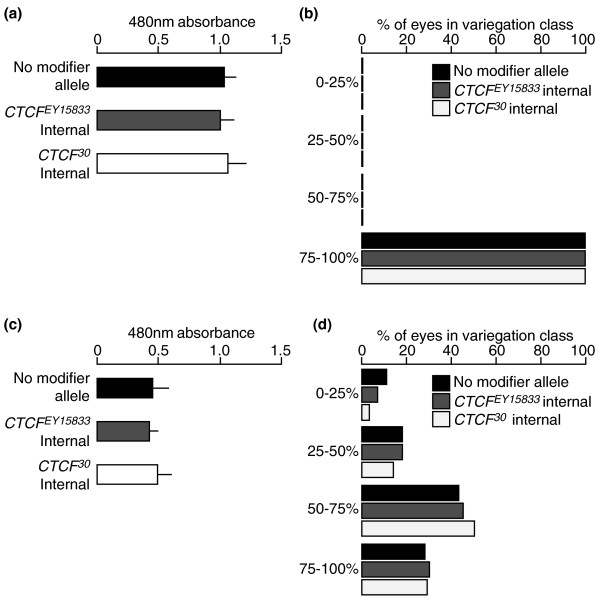
Absence of maternal or paternal effects from mutant dCTCF on Dp(1;f)LJ9 garnet expression. External control progeny (no modifier allele) have the same genotype as internal control progeny (y1zag53d/Dp(1;f)LJ9; TM3, Sb Ser/+) but are generated from a separate cross with parents that have never encountered a mutant CTCFX allele. (a) Maternally inherited Dp(1;f)LJ9 CTCFX internal control eye pigment levels; no significant difference in pigment levels was observed between external control progeny (no modifier allele) and internal control progeny from fathers carrying CTCFX (CTCFX internal), demonstrating that no paternal effect occurs. (b) Phenotypes of maternally inherited Dp(1;f)LJ9 ranging from 0% to 100% pigmentation; No modifier allele n = 300, CTCFEY15833 internal n = 300, CTCF30 internal n = 300. No garnet variegation was detected from the internal controls. (c) Paternally inherited Dp(1;f)LJ9 CTCF internal control eye pigment levels; no significant difference in pigment levels was observed between the external control progeny (no modifier allele) and internal control progeny from mothers carrying CTCFX (CTCFX internal), demonstrating that no maternal effect occurs. (d) Phenotypes of paternally inherited Dp(1;f)LJ9 ranging from 0% to 100% pigmentation; no modifier allele n = 300, CTCFEY15833 internal n = 300, CTCF30 internal n = 300. No significant change in garnet variegation was detected from the internal controls. Red eye pigment levels are measured by absorbance at 480 nm, and pigment quantification mean values for each group are based on n = 5 samples (40 heads total); error bars represent standard deviation.